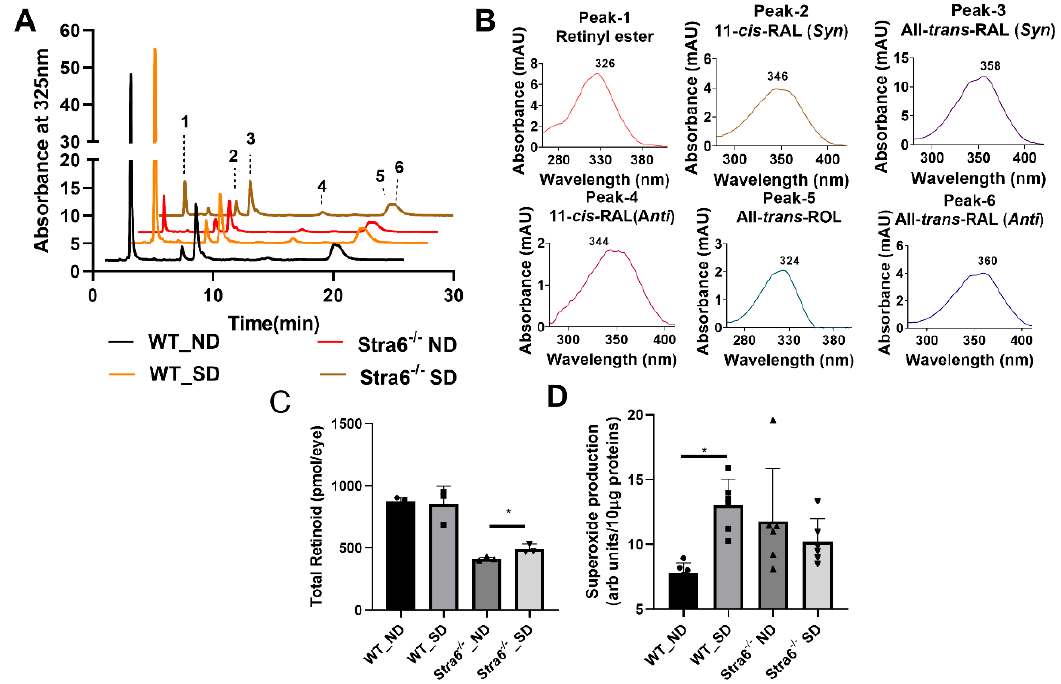
Figure 3. Ocular retinoids and oxidative stress in short-term diabetic and non-diabetic WT and Stra6 -/- mice. ( A ) HPLC trace at 325 nm of ocular lipid extracts of diabetic and non-diabetic WT and Stra6 -/- mice. Note that the retinal diastereomers were converted to the corresponding retinal oximes and exist as syn and anti stereoisomers. ( B ) Spectral character of individual ocular retinoids. ( C ) Total ocular retinoids of diabetic and nondiabetic WT and Stra6 -/- mice. ( D ) Superoxide levels in freshly isolated retinal tissue using the lucigenin method from diabetic (SD) and nondiabetic (ND) WT and Stra6 -/- . Values from panel ( C ) represent values from at least three eyes and values in ( D ) represent values from at least six retinas per genotype and condition. The values are expressed as means ± SD. The statistical analysis was performed using a two-tailed t -test. * p ≤ 0.05.